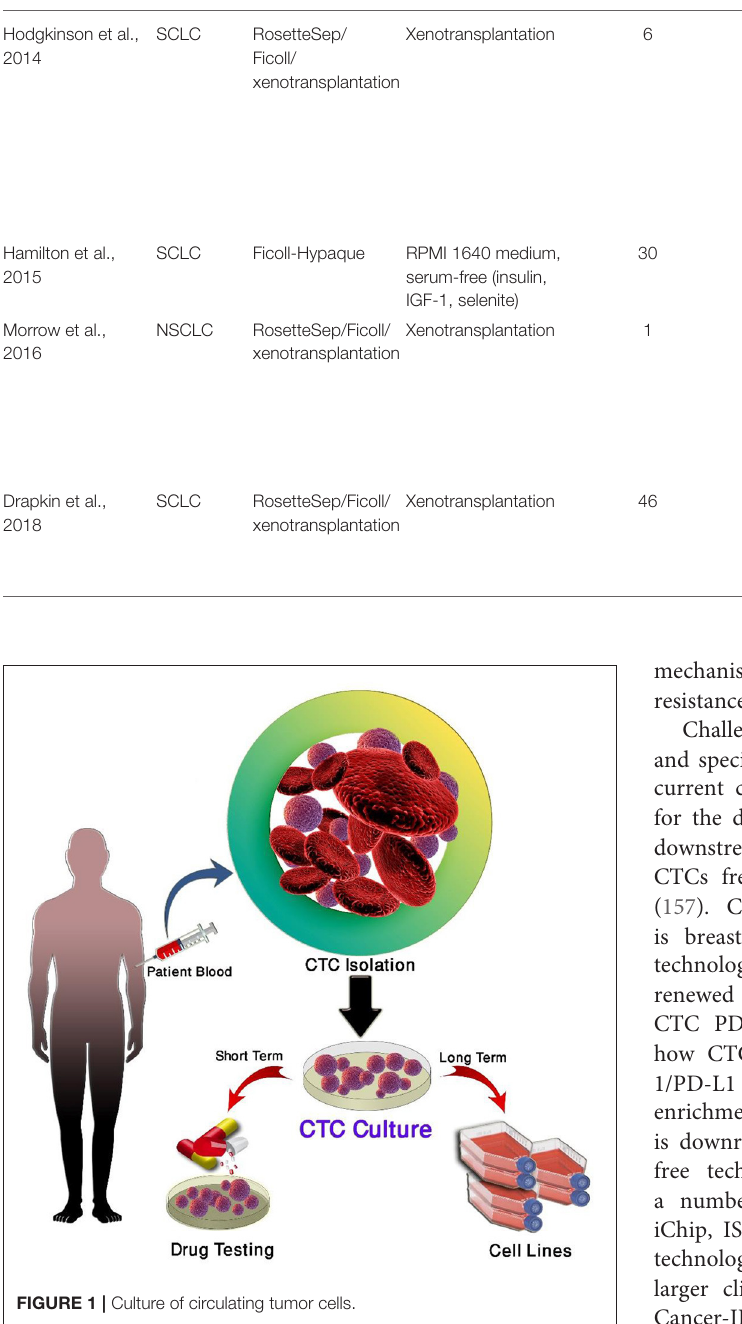
selection of patients as well as broadening the current knowledge of metastasis